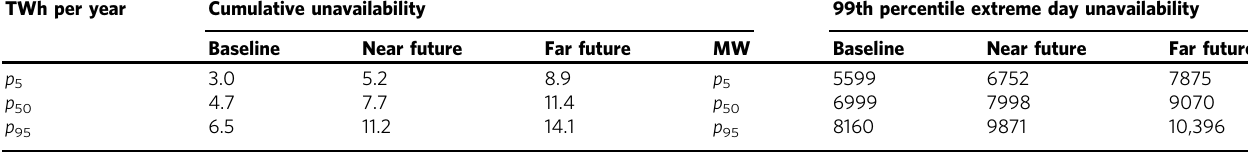
These data summarise the distributions found in Fig.